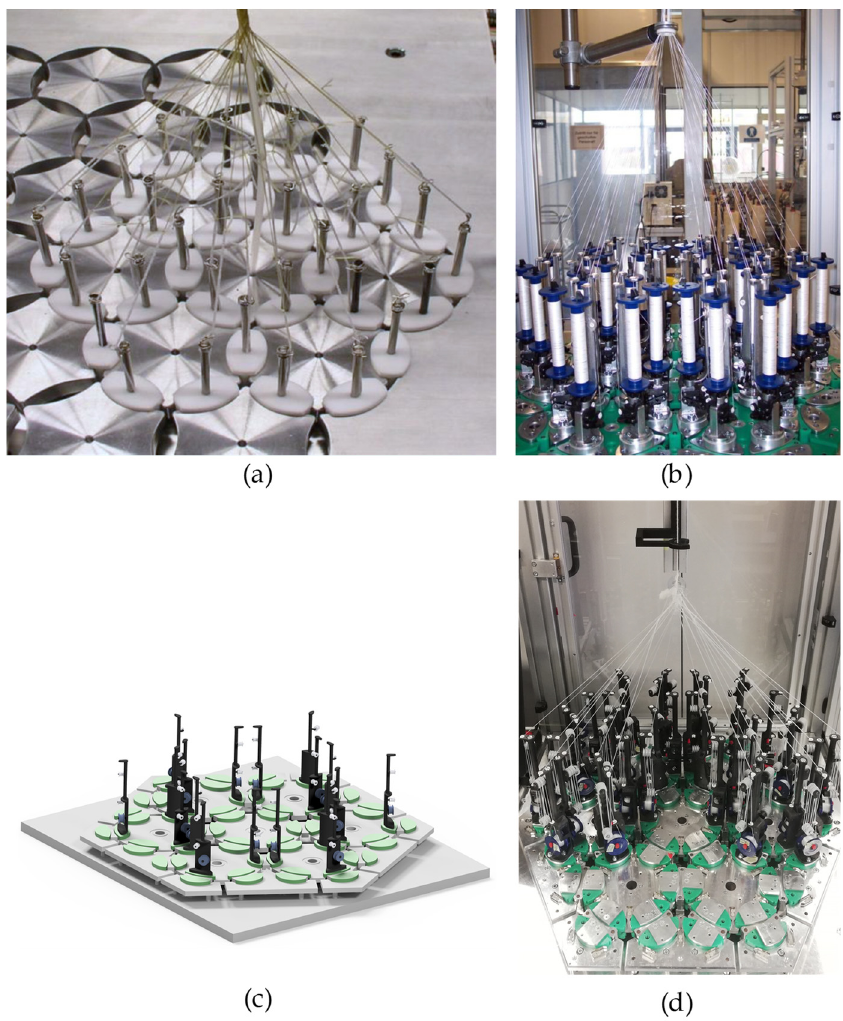
Figure 9. Illustration of the different generations of the hexagonal 3D braiding machine: ( a ) Advanced Fibrous Materials Laboratory (University of British Columbia, Vancouver, Canada) (AFML) hexagonal 3D rotary braider (first generation) with 37 horn gears (adapted from ref. [23]); ( b ) second generation of the 3D hexagonal braider at ITA, with seven horn gears and switching devices (adapted from ref. [27]); ( c ) CAD scheme of the machine bed from the third generation on; ( d ) machine bed of the fourth generation of the 3D hexagonal braiding machine.